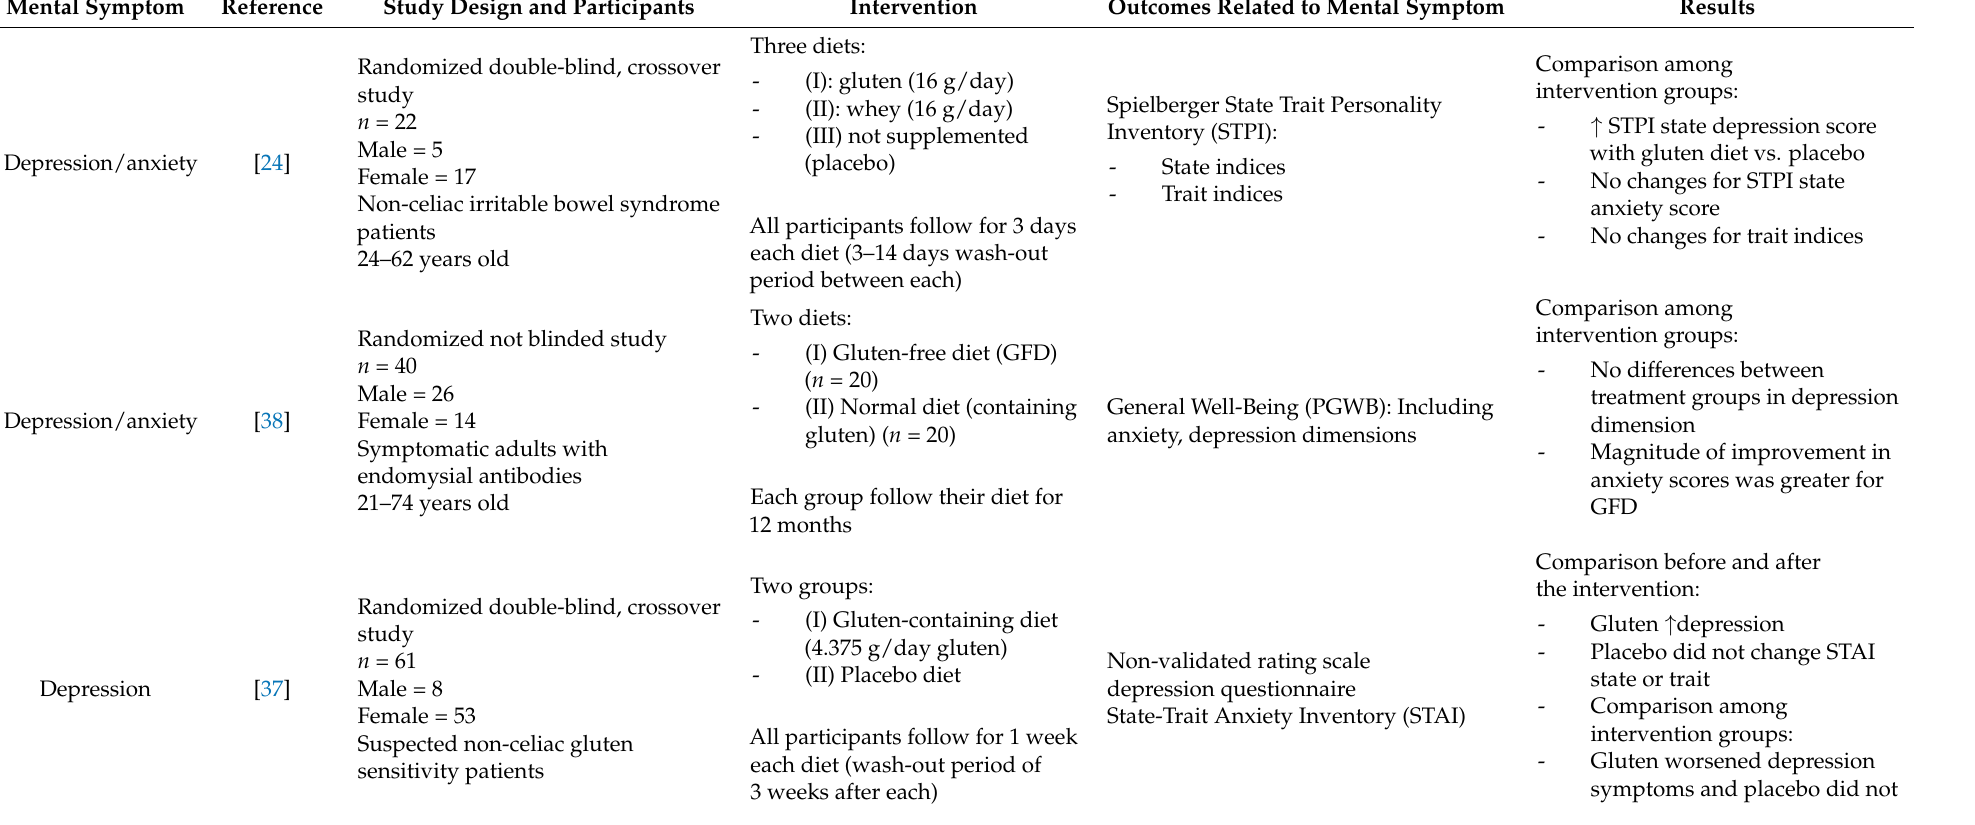
Table 1. Characteristics and results of clinical and randomized controlled trials related to depression, anxiety and cognitive mental